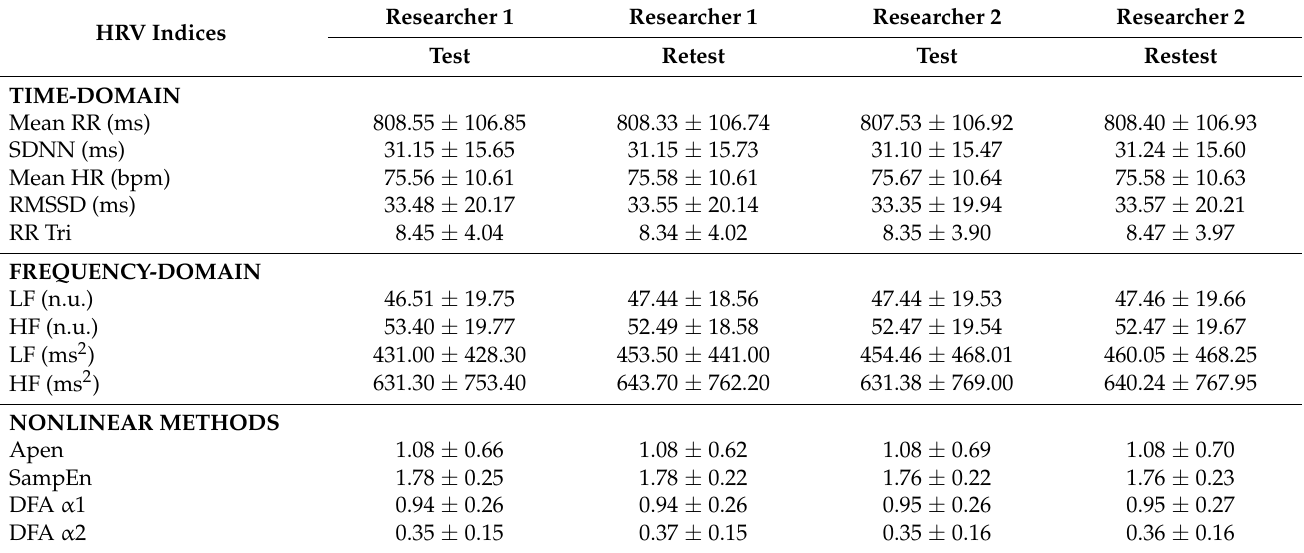
Table 2. Mean values and standard deviation of HRV in post-COVID-19 individuals in the supine position.